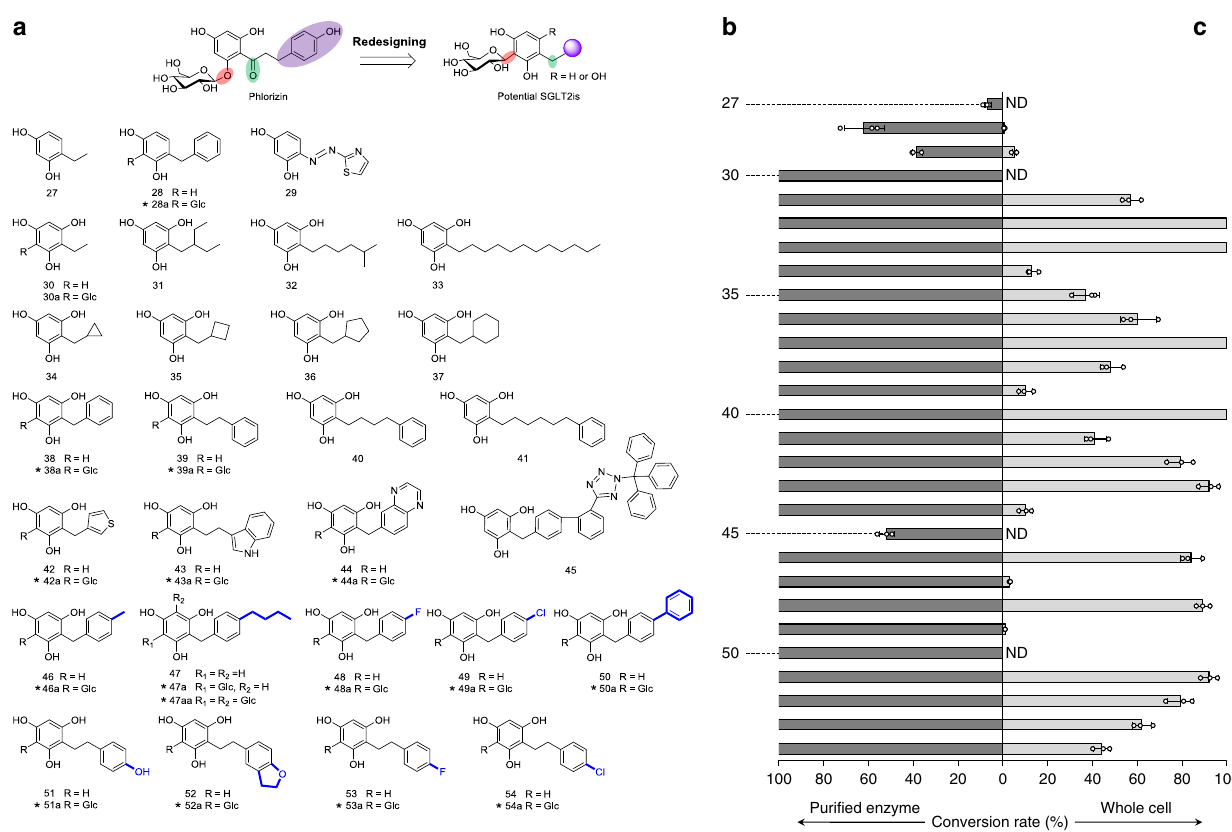
Fig. 2 Establishing a chem-biosynthesis method for potential SGLT2 inhibitors. a The redesigned structures of the substrates and corresponding glycosylated products. b Conversion rate of each substrate with puri fi ed AbCGT. c Conversion rate of each substrate with whole-cell system. *Not reported C -glycosides previously. ND not detected. Experiments were performed at 30 °C in M9 medium for 12 h with shaking (200 rpm), and the conversion rates represent mean ± SD of three independent replicates ( n =